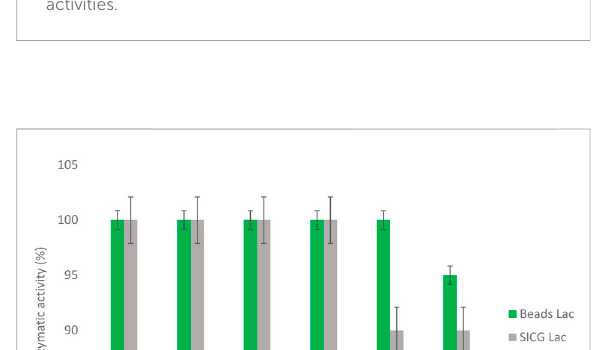
FIGURE 6 Thermal stability of laccase under different temperature levels (4 – 100 ° C).